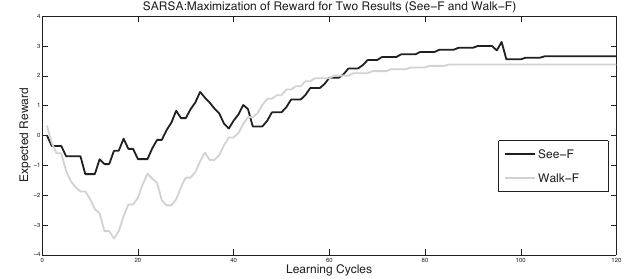
Figure 4. The curve of Q-learning for two converged behaviors: See-F and Walk-F.